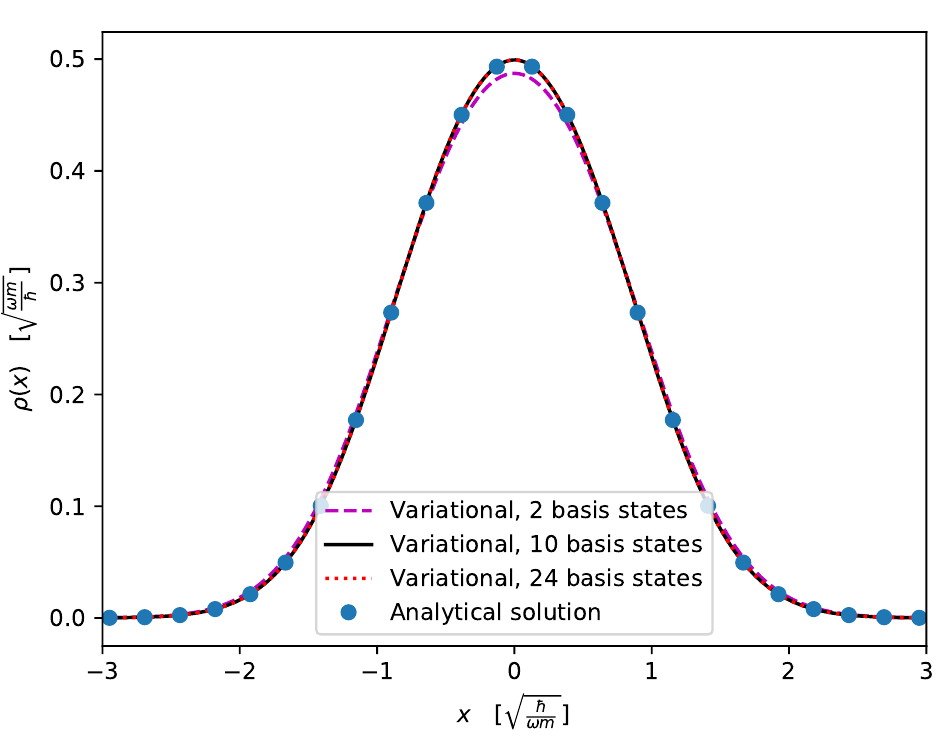
Figure 4: Position space density for the ground state for one of the particles for dif- ferent basis sizes compared to the analytical result for the 1 + 1 system in a harmonic (cid:113) m = well at g ħ h 3 ω